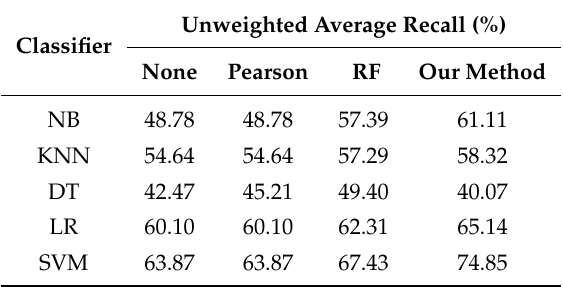
Table 12. Unweighted average recall of speaker-dependent speech emotion recognition on SAVEE.